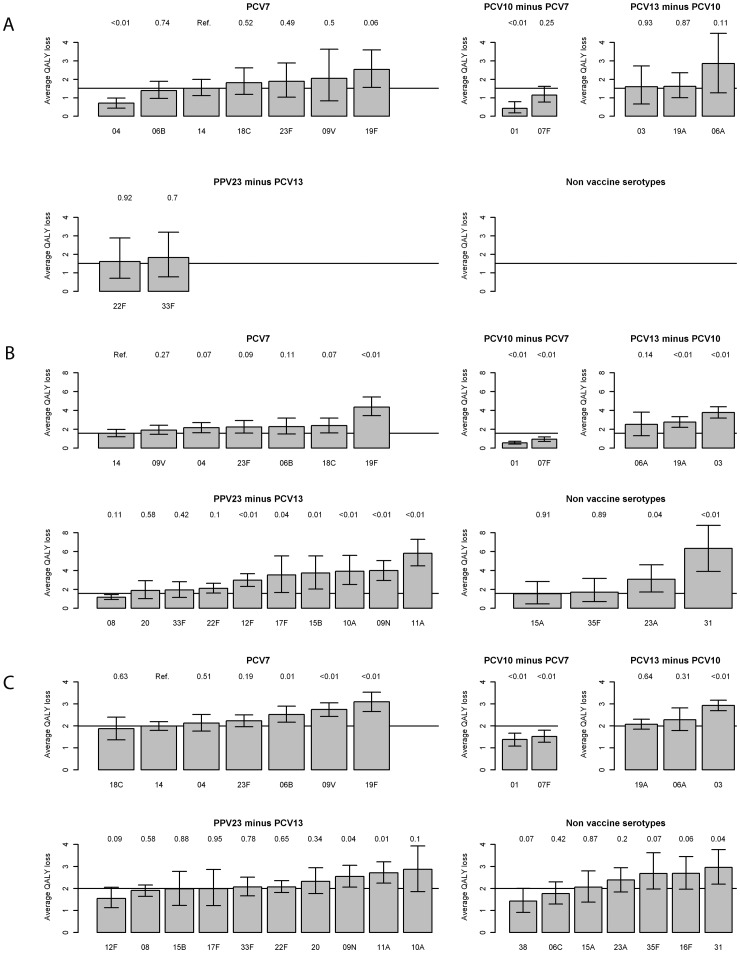
Serotype specific differences in QALY loss (discounted – see text) between serotypes and age groups.The line shows the absolute QALY loss for serotype 14, which was used as reference. The p-values of the bootstrap comparison are shown above each bar. The whiskers show the 95% CI based on 1000 bootstrap samples of the mean. When there are no serotypes with >50 cases an empty plot is shown. a) Under 5 years; b) 5–64 years; c) 65 and over.